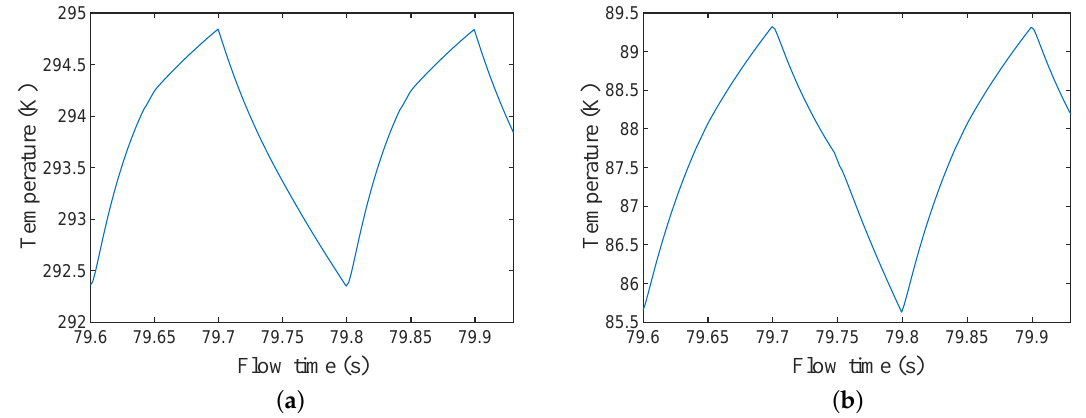
Figure 11. ( a ) Temperature changes during cooling and heating periods at the regenerator’s hot end. ( b ) Temperature changes during cooling and heating periods at the regenerator’s cold